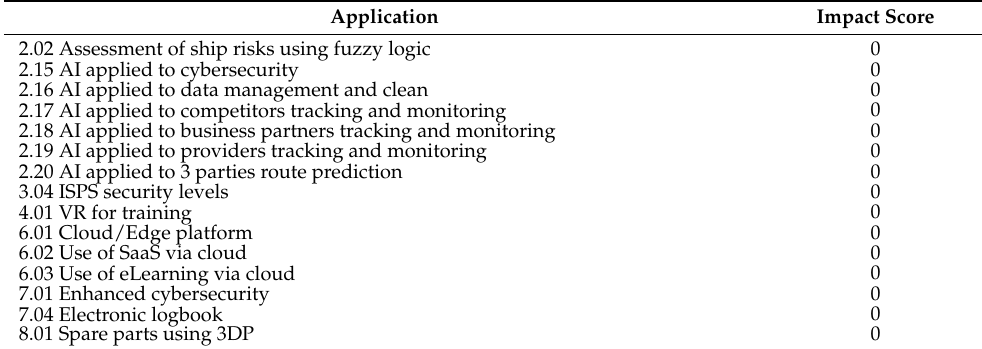
Table 11. Bottom applications on Quality performance dimension.